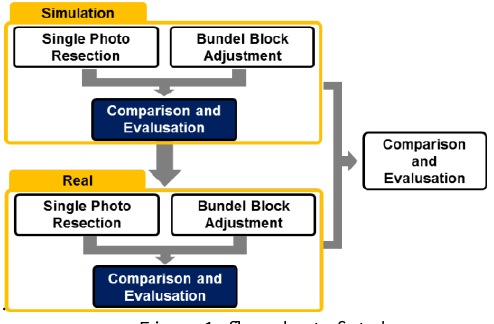
Figure 1. flow chart of study